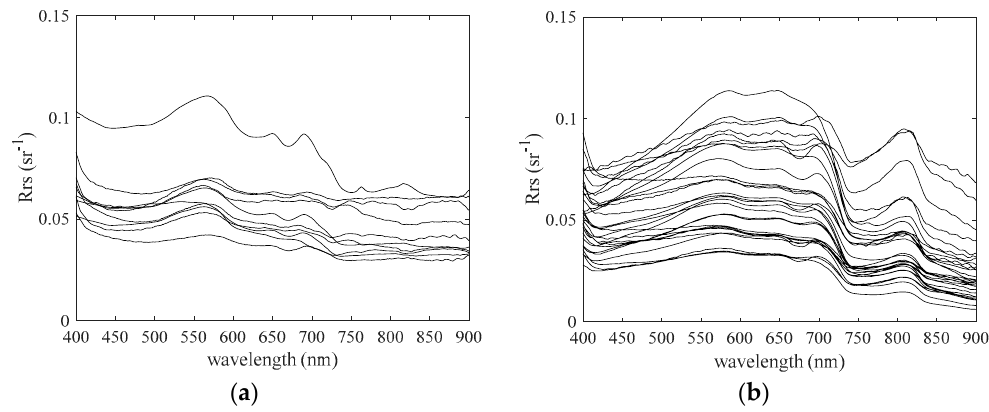
Figure 3. Acquired spectral reflectance ( R rs ) characteristics. ( a ) Lake Shinji and Lake Nakaumi (SJNU); ( b ) Vaal Dam Reservoir (VDR). Table 4. Chlorophyll-a (Chla) and turbidity range of field data.